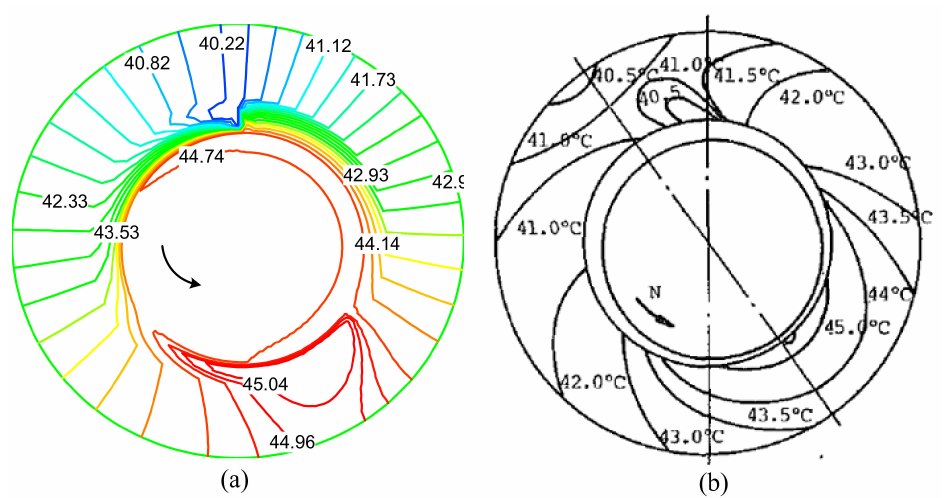
Figure 8. Structure temperature analysis results in comparison with the experimental data given in Mitsui et al. [17]: ( a ) results obtained by the proposed model; ( b ) the experimental results.